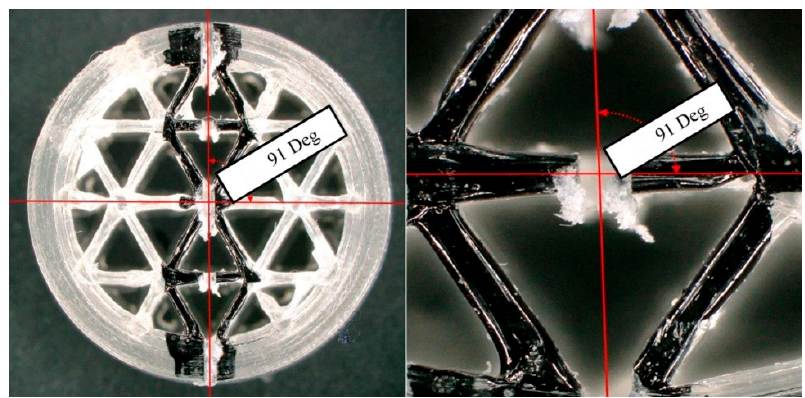
Figure 11. The accuracy of the cuts made on the 2.4 mm ILD sample.